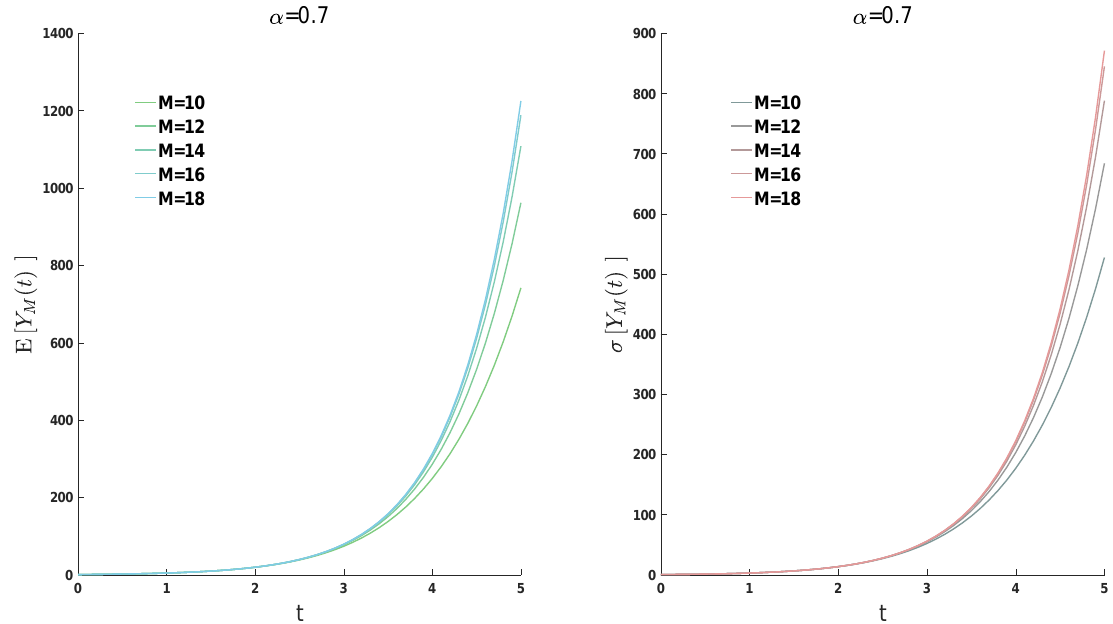
Figure 2 Approximations of the mean (left) and the standard deviation (right) of the solution SP to the random IVP (2) with α = 0 . 7 and λ = 5 / 4 using different orders of truncations M = 10 , 12 , 14 , 16 , 18 over the time interval [ 0 , 5 ] .